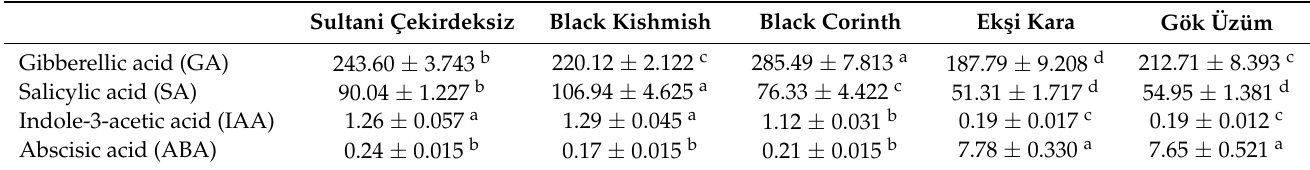
Table 2. Hormone contents (ng µ L − 1 ) of two stenospermocarpy varieties (Sultani Çekirdeksiz and Black Kishmish); one parthenocarpic variety (Black Corinth) and two seeded varieties (Ek¸si Kara and Gök Üzüm) in 2020